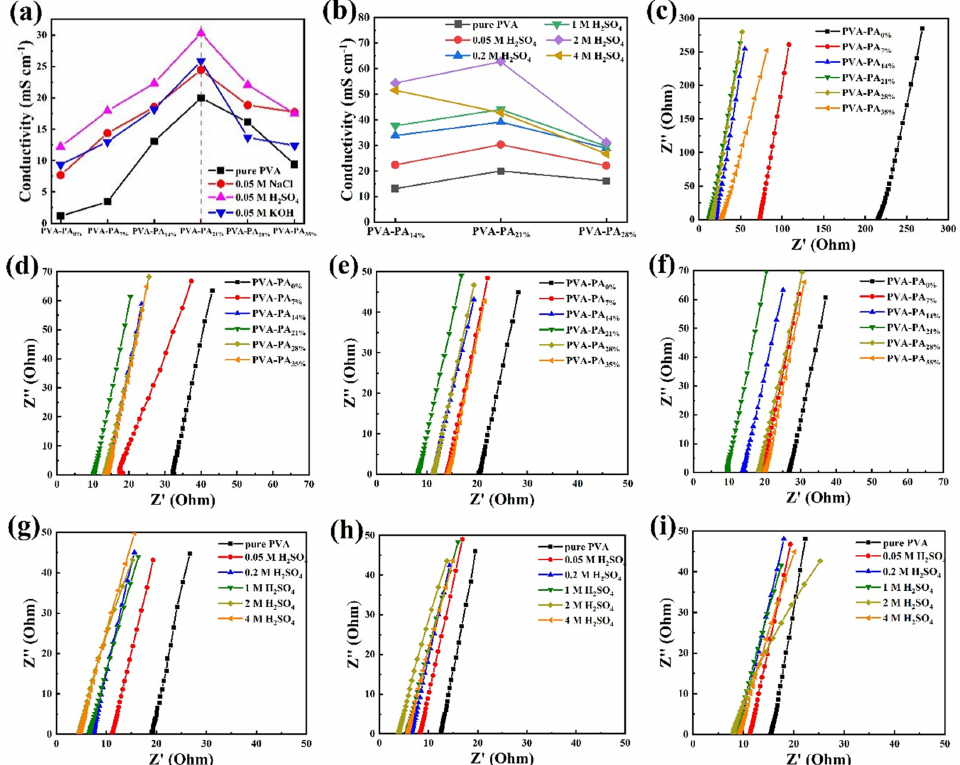
Figure 2. PVA-PAx-Z M Y hydrogel electrolyte ionic conductivity ( a ) without and with 0.05 M different electrolytes, ( b ) with different concentrations of H 2 SO 4 . Impedance tests of PVA-PAx-Z M Y hydrogel electrolyte added ( c ) without addition, with ( d ) NaCl, ( e ) H 2 SO 4, and ( f ) KOH. Impedance tests of ( g ) PVA-PA 14% , ( h ) PVA-PA 21% , ( i ) PVA-PA 28% with different concentrations of H 2 SO 4 . Then, the effect of different concentrations of H 2 SO 4 on the conductivity of the hy- drogel electrolyte was explored by increasing the concentration of H 2 SO 4 (Figure 2b). When the concentration of H 2 SO 4 is between 0–2 mol L − 1 , the ionic conductivity of the hydrogel electrolyte with the same PA content increases continuously with the increase of H 2 SO 4 concentration. When the H 2 SO 4 concentration is the same, the ionic conductivity of different hydrogel electrolytes increases first and then decreases with the increase of PA content. Among them, the ionic conductivity of PVA-PA 21% -2 M H 2 SO 4 hydrogel elec- trolyte is the largest of 62.75 mS cm − 1 , which was used as the follow-up research material. However, the ionic conductivity decreased when the concentration of H 2 SO 4 increased to 4 mol L − 1 . From the appearance, the hydrogel electrolyte was soft and difficult to maintain the original shape, which may be related to the existence of phytic acid. It presented good acid resistance, but phytic acid will be hydrolyzed into inositol and phosphate ester in a strong acid environment [26].